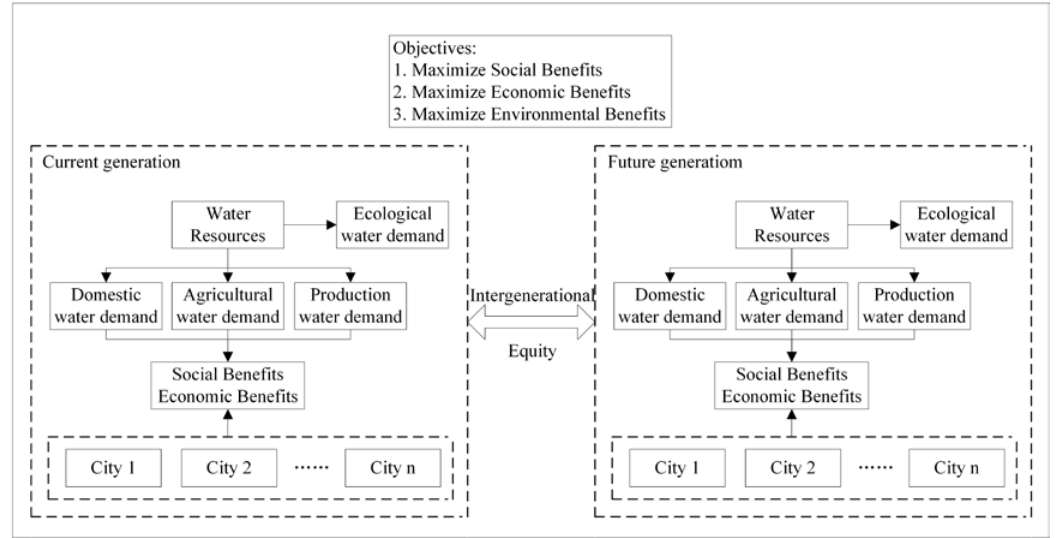
Figure 1. Flowchart of the methodology.